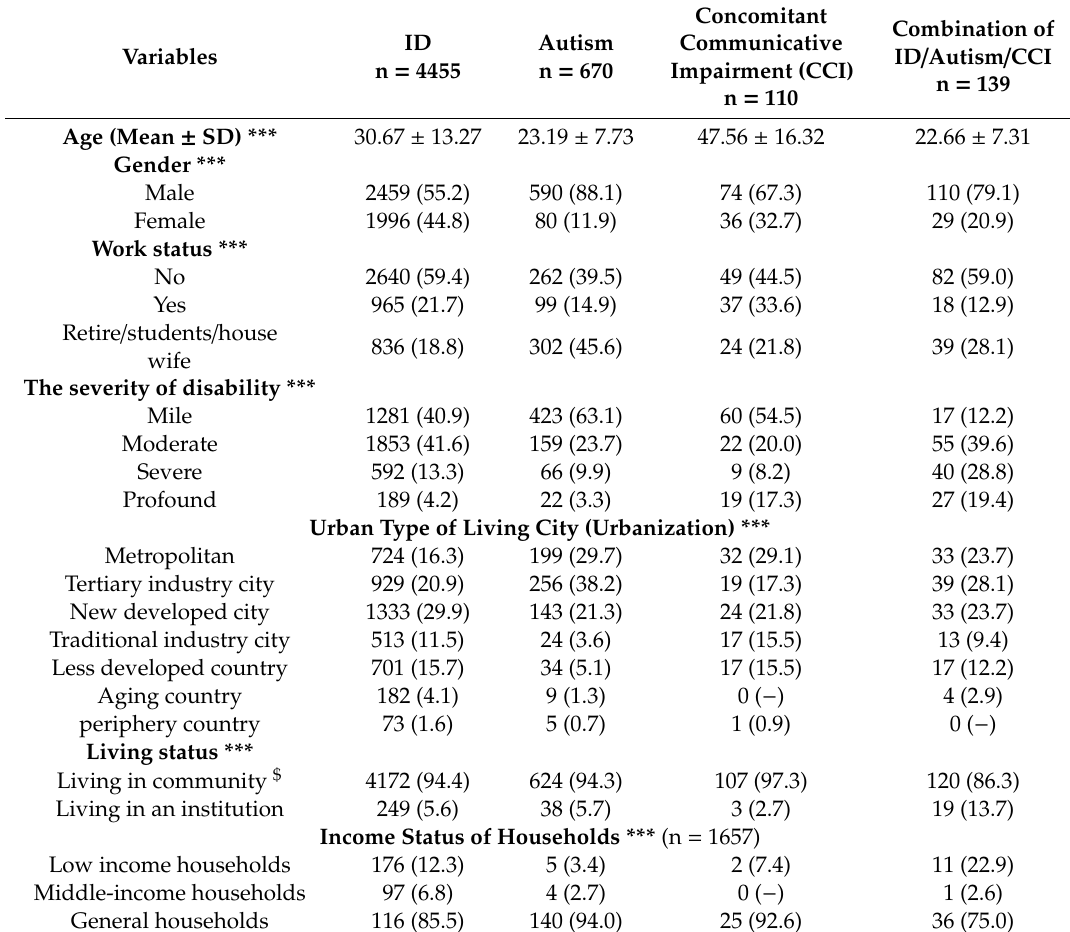
Table 2. The characters of four subgroups (N =